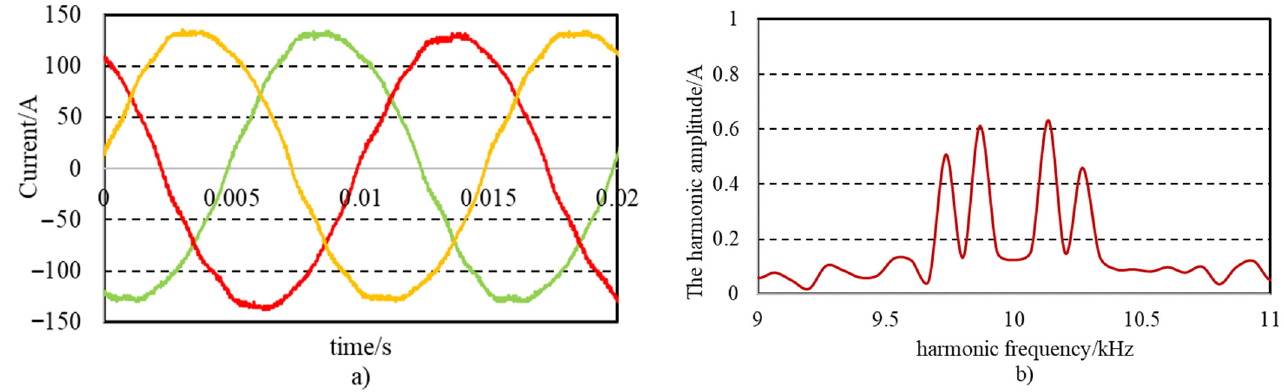
Figure 11. ( a ) Three-phase current; ( b ) A-phase current spectrum.